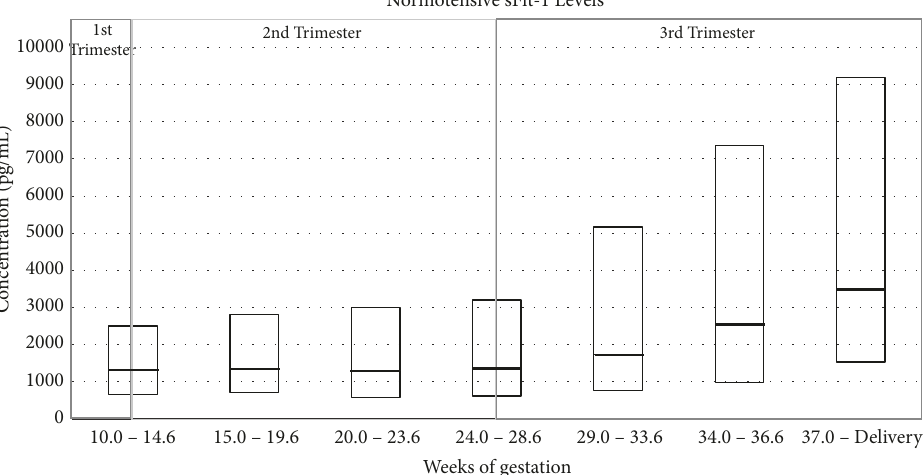
Figure 4: sFlt-1 levels (pg/mL) measured in normotensive women during different weeks of gestation (based on data from Roche Study no. CIM